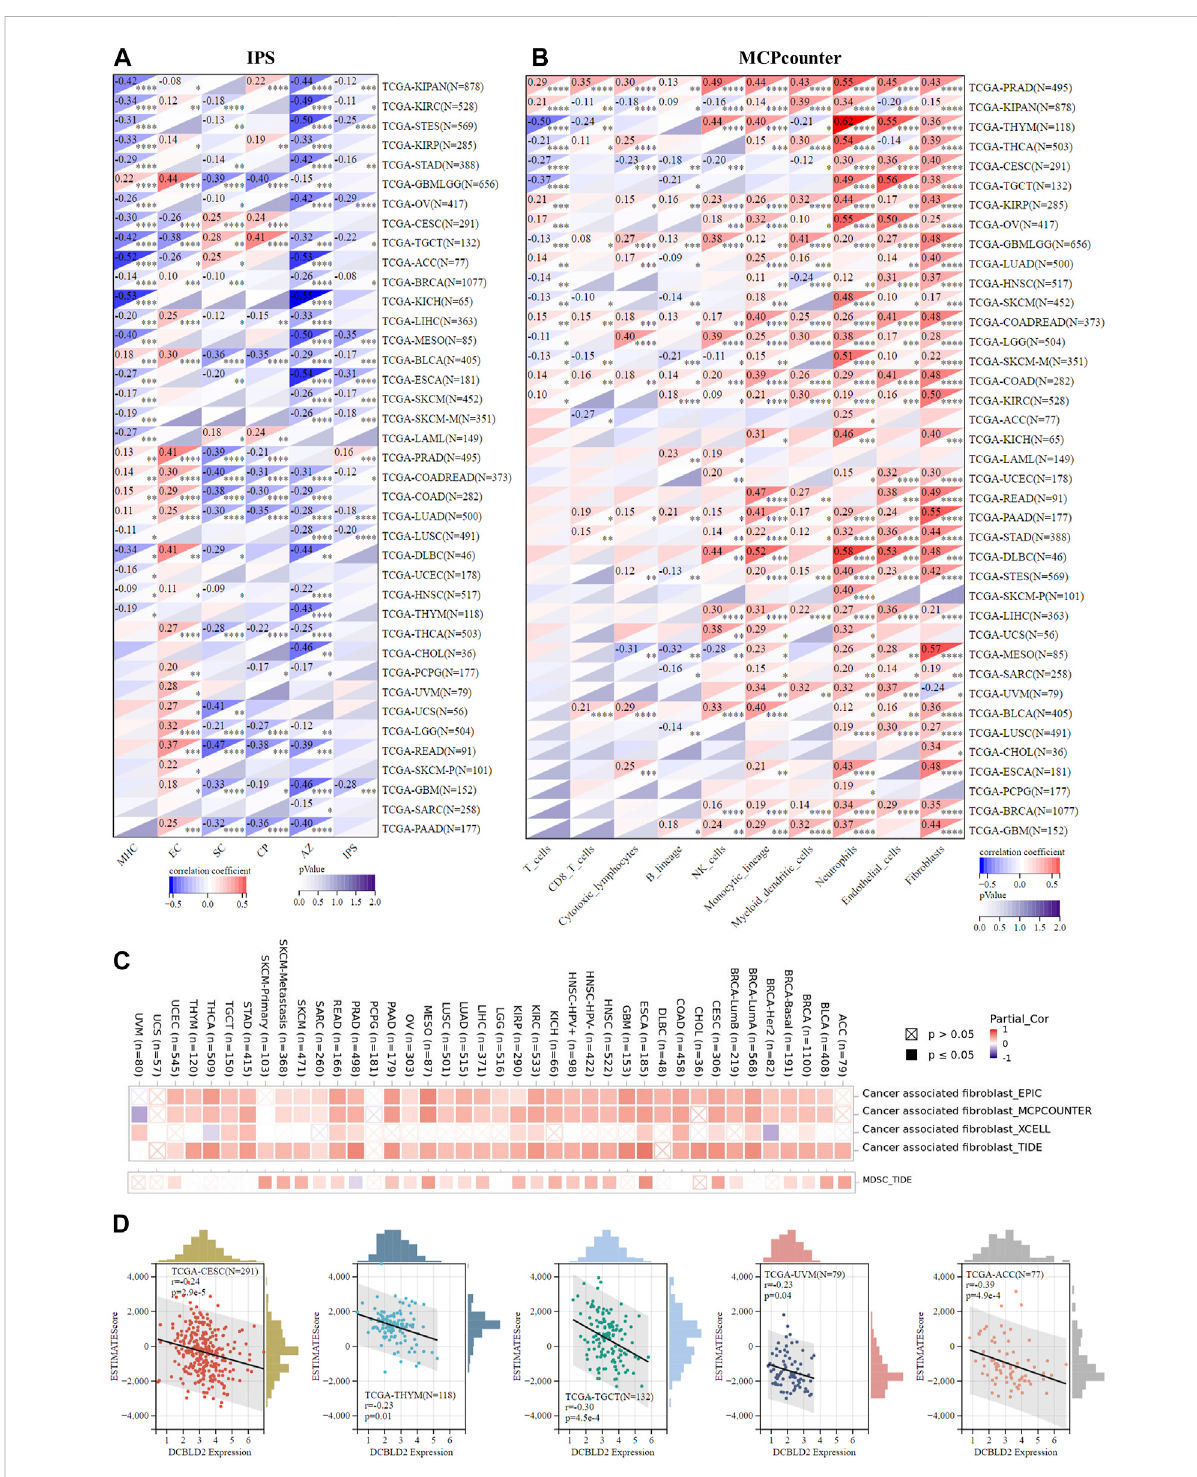
FIGURE 5 Associationof DCBLD2 withimmuneregulation. (A) Heatmapshowingcorrelationsbetween DCBLD2 expressionandIPSscoreofstandardized pan-cancer data set. The MHC, EC, SC, CP, AZ, and IPS in fi ltration scores in each tumor were evaluated according to gene expression. (B) Heatmap showing correlations between DCBLD2 expression and MCPcounter score of standardized pan-cancer data set. The T cells, CD8 T cells, Cytotoxic lymphocytes, B lineage, NK cells, Monocytic lineage, Myeloid dendritic cells, Neutrophils, Endothelial cells and Fibroblasts in fi ltration scores in each tumor were evaluated according to gene expression. (C) Heatmap showing correlations between DCBLD2 expression and immune in fi ltration of cancer-associated fi broblasts (CAFs) and myeloid-derived suppressor cells (MDSCs) via TIMER 2.0 database. (D) Correlation analysis between DCBLD2 expression and ESTIMATE score of standardized pan-cancer data